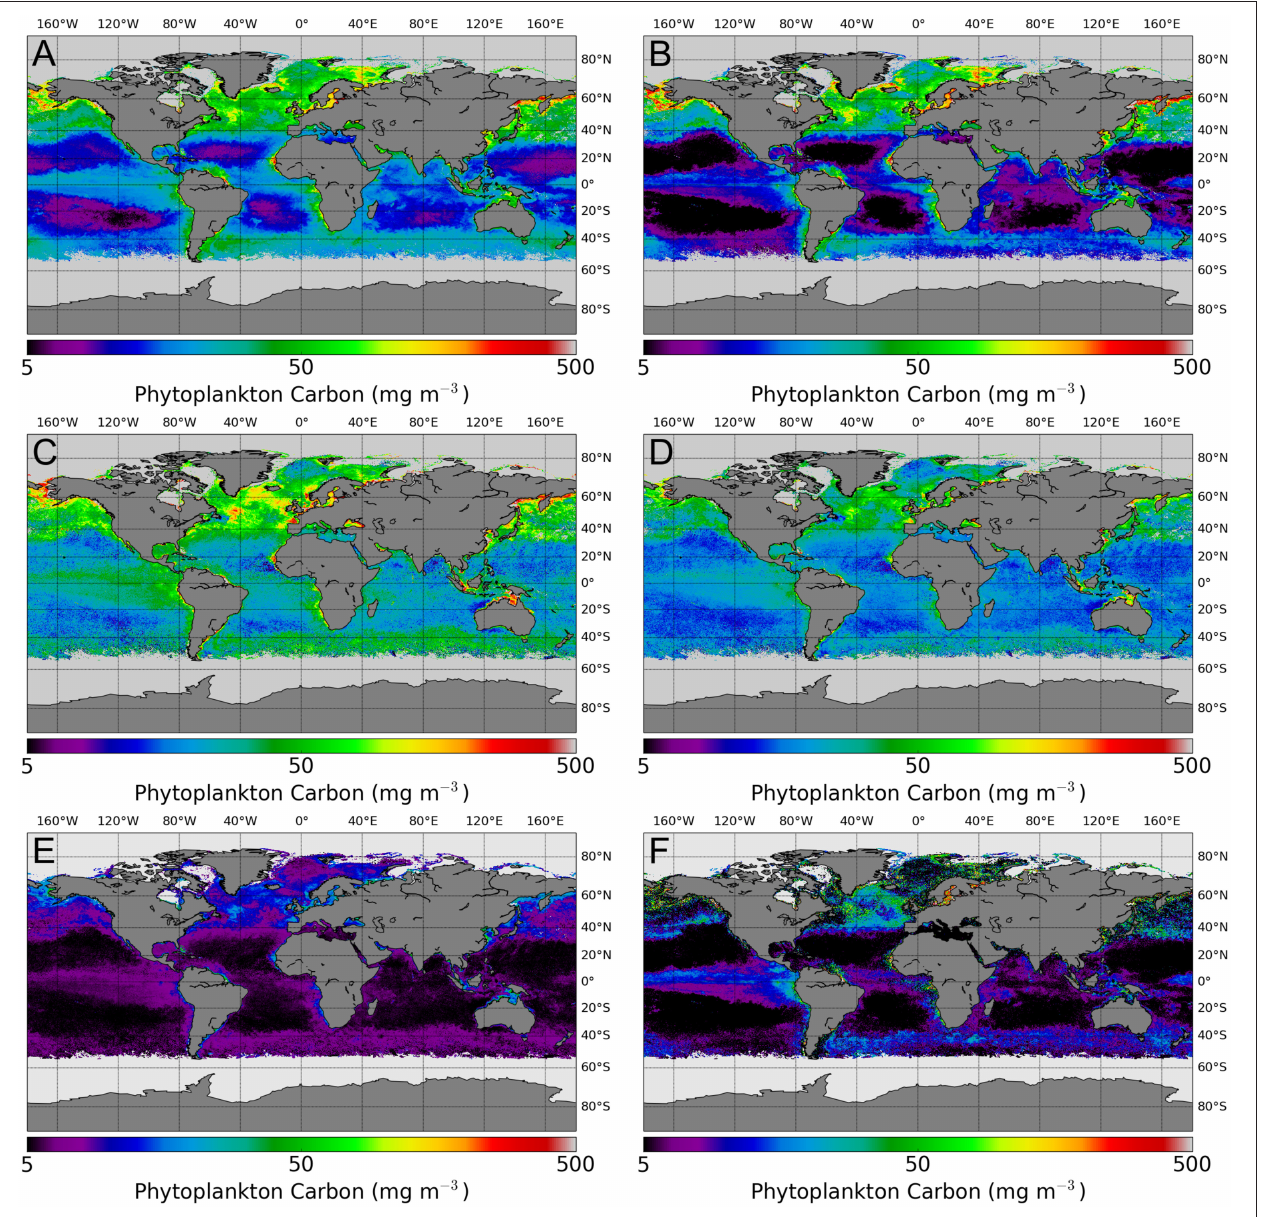
FIGURE 9 | An example of the C phy product for May 2005, estimated using each of the algorithms (A–F) applied to the monthly OC-CCI data. Black color in the gyres indicate values close or below 5 mgCm − 3 , light gray indicates invalid retrieval or unavailable input